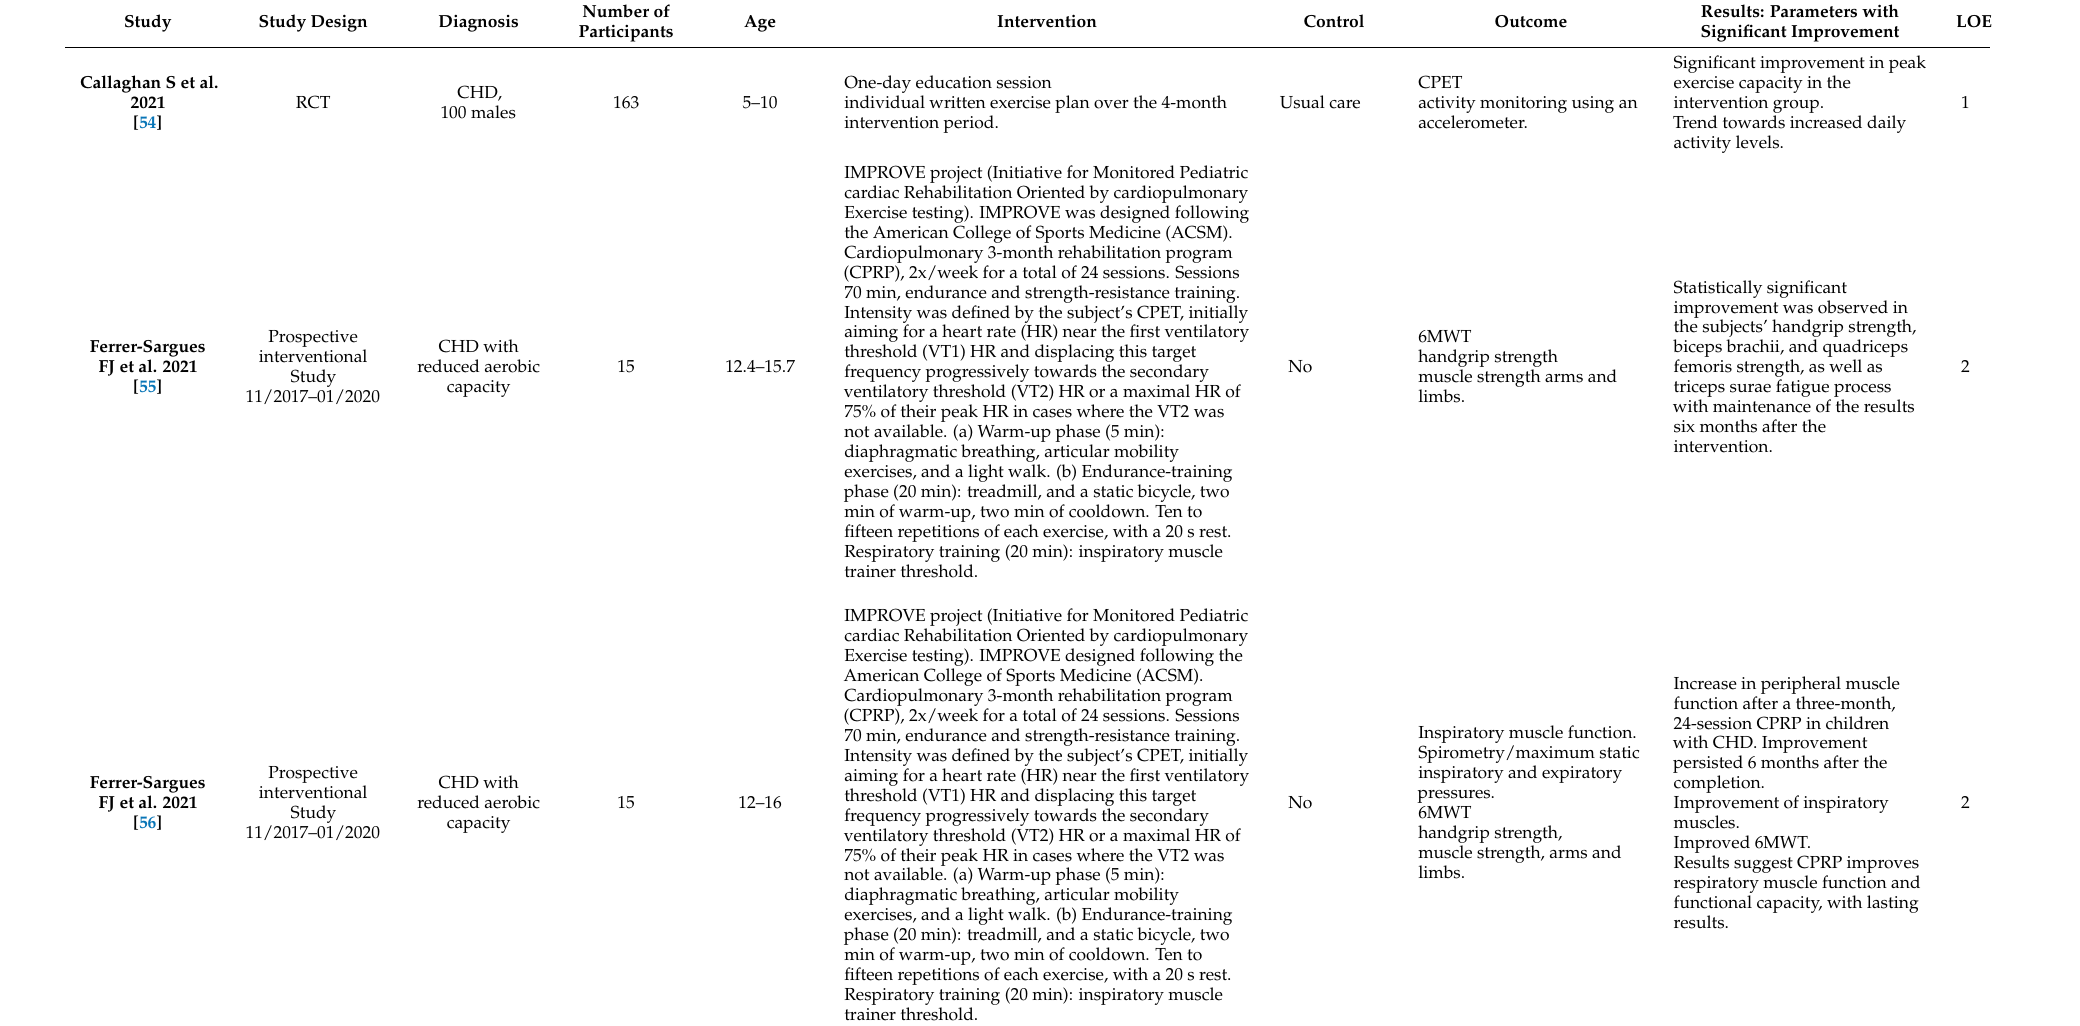
Table 1. Randomized controlled trials and prospective